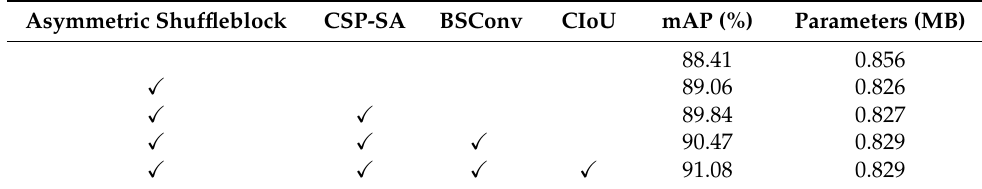
Table 7. Ablation experiments of